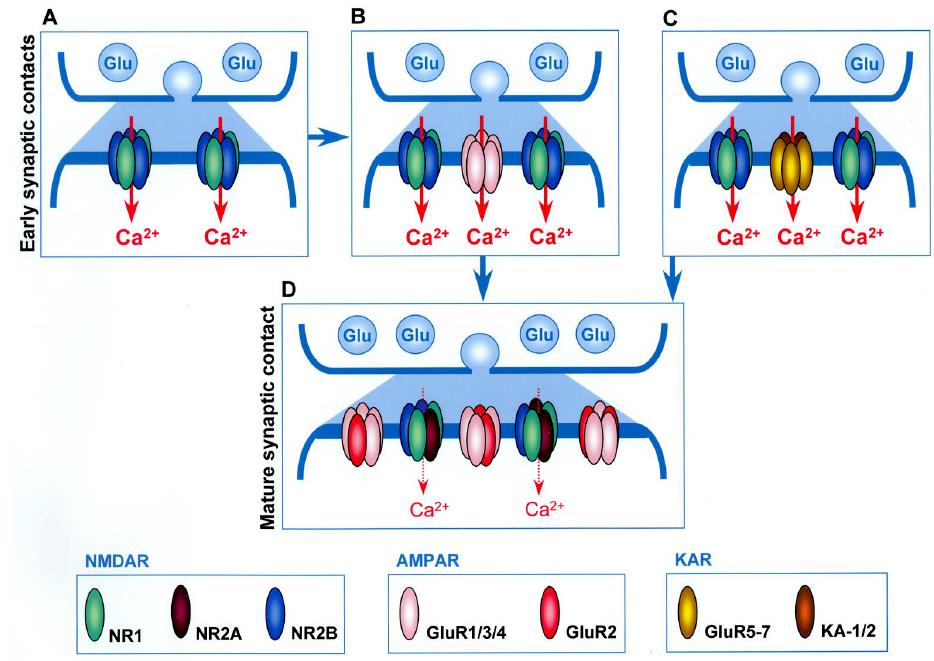
FIGURE 1. Schematic illustration of characteristic changes in the synaptic distribution and subunit composition of AMPA, NMDA, and KA receptors during development. Early in development, there are a large proportion of synapses containing only NMDARs (A) that subsequently acquire AMPARs to produce fully functional synapses (B and D). At hippocampal and intracortical synapses, once AMPARs are present there is a developmental increase in the relative ratio of GluR2 (B ! D) compared to other AMPAR subunits on the neuronal surface. At cerebellar stelate cell synapses, a rapid incorporation of GluR2-containing AMPARs can be induced by synaptic activity. In hippocampal and neocortical neurons, early functional NMDARs are composed of combinations of NR1 and NR2B subunits (A). The NR2A subunit is gradually expressed from early postnatal ages and in the adult forebrain NMDARs are mainly composed of NR1/NR2A/NR2B heteromers. In thalamocortical synapses, KARs are exchanged with mature GluR2-containing AMPARs during development and in response to activity and NMDAR activation (C !